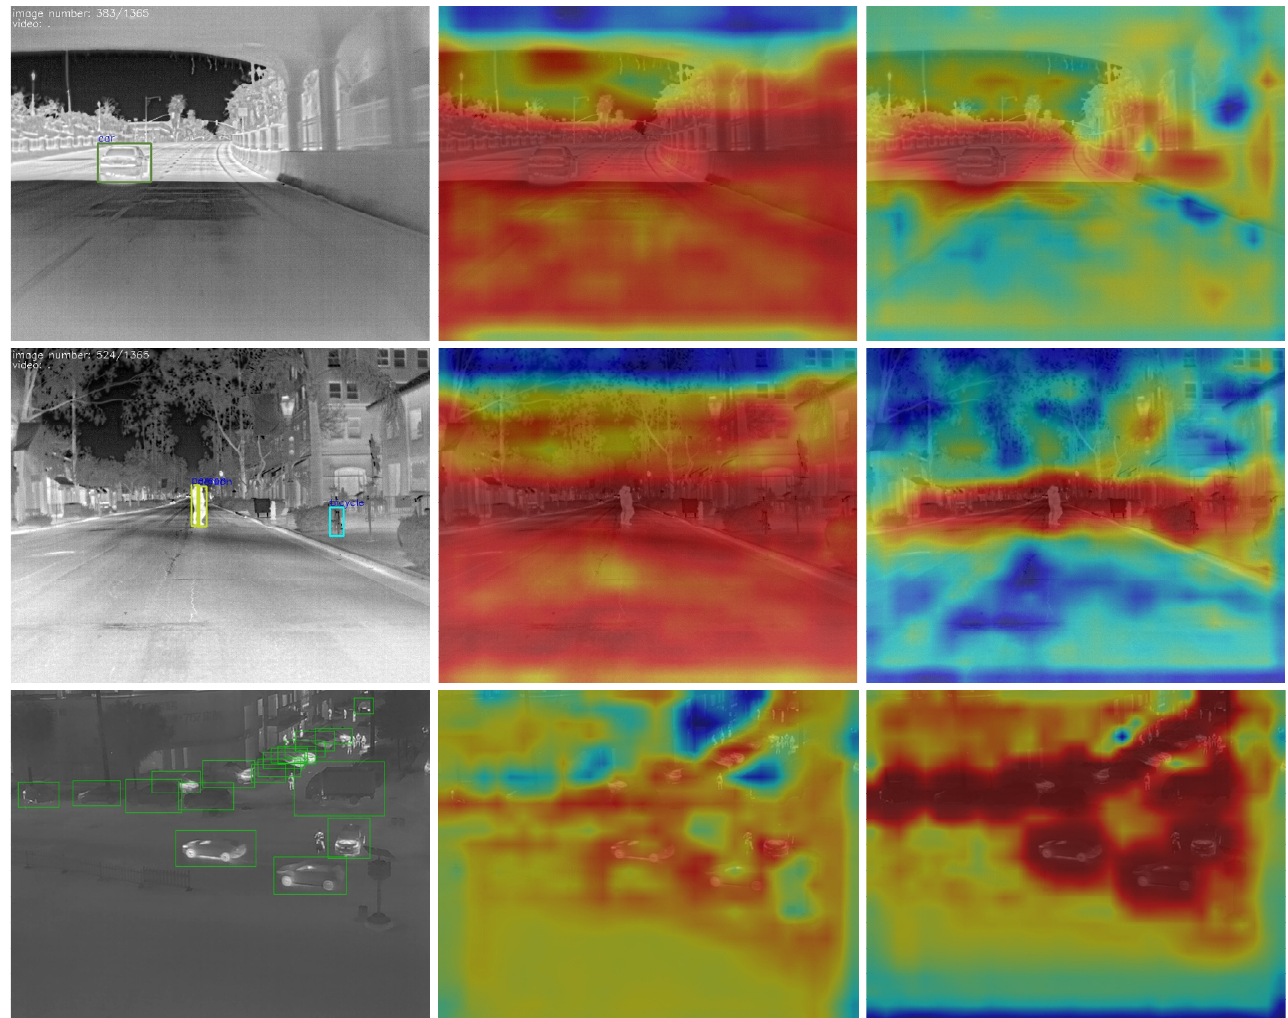
Figure 10. These are some images and feature maps extracted from them. The first of each line is the labeled infrared image. The second and third are the feature thermal images output by baseline and our method, respectively.